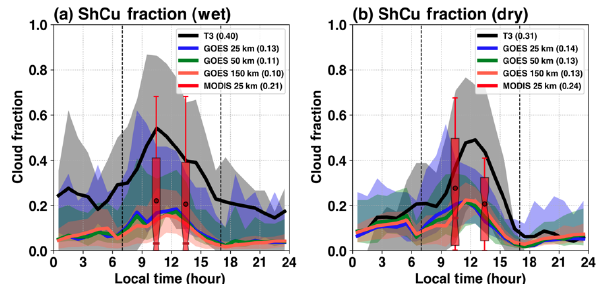
Figure 9. Diurnal comparison of shallow cumulus (ShCu) cloud fraction estimates between ARM T3 (black lines and grey shading), MODIS (red box whiskers) and GOES (multi-color, contingent on spatial domain) centered on the ARM T3 site for (a) wet and (b) dry season breakdowns during February–December 2014. Values in the legend reflect an averaged value during daytime (07:00–17:00LT, vertical dashed lines) hours. Shaded regions reflect the observa- tional interquartile range. MODIS box-and-whisker notches show median values, circles show means, boxes show interquartile ranges and whiskers show 10th and 90th percentiles,